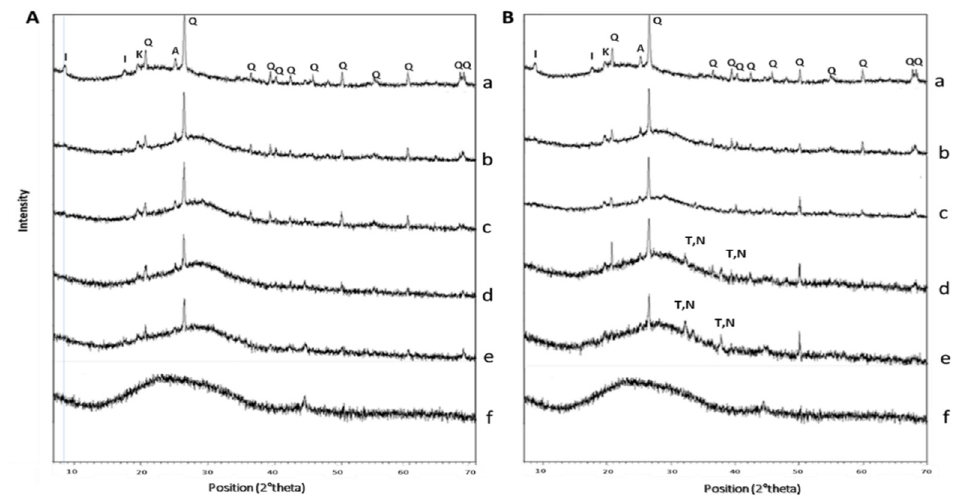
Figure 5. XRD patterns for samples GP, WG, and GP/WG from series: ( A ) 37–53 µ m and ( B ) 75–105 µ m. Pattern a = MK; b = GP; c = GP/WG20%; d = GP/WG50%; e = GP/WG60% f = WG. Crystalline phases identification label: Q = Quartz, K = Kaolinite, I = Illite, A = Anatase, T = Thermonatrite and N = Trona Na 3 (HCO 3 ) (CO 3 )·2H 2 O.